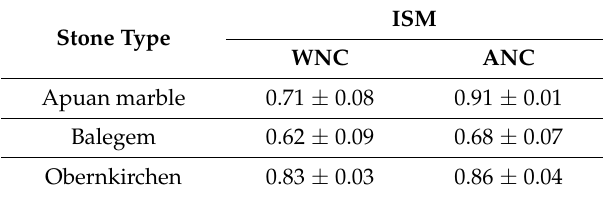
Table 7. Index of surface modification (ISM) for the lithotypes treated with WNC or ANC. Stone